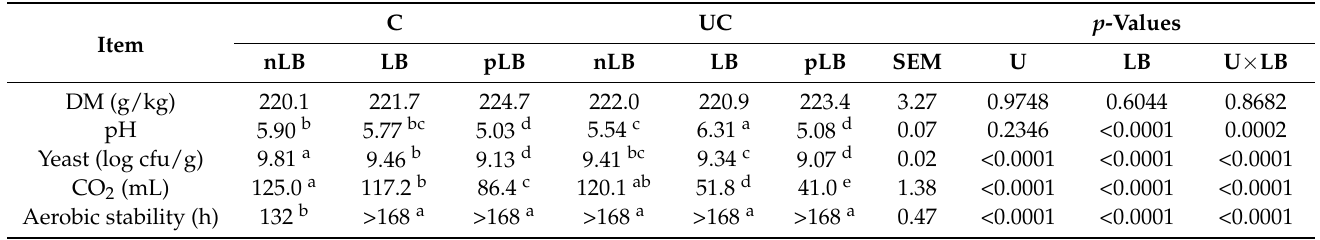
Table 2. Effect of urea treatment and L. buchneri forms on the aerobic stability of corn silages.